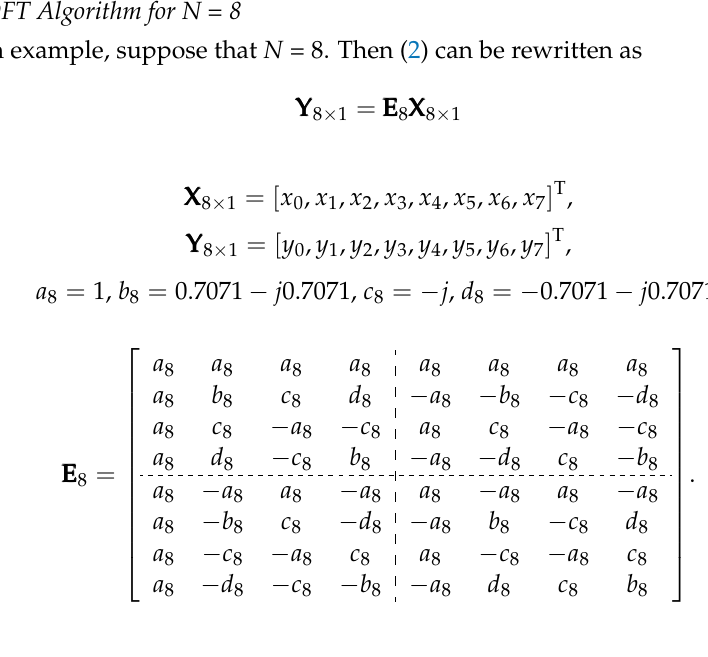
Figure 1. The data flow graph of the proposed algorithm for computation of 4-point